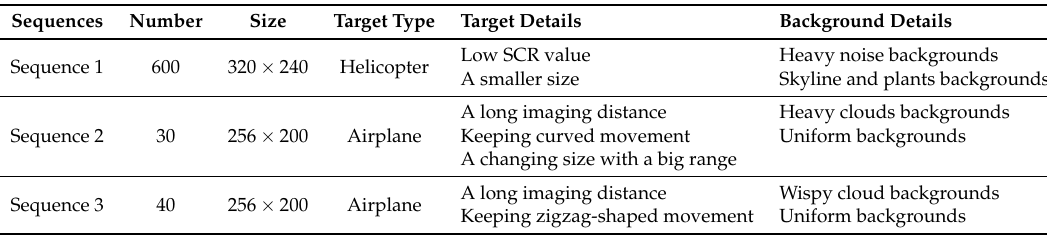
Table 1. Details of the evaluation data